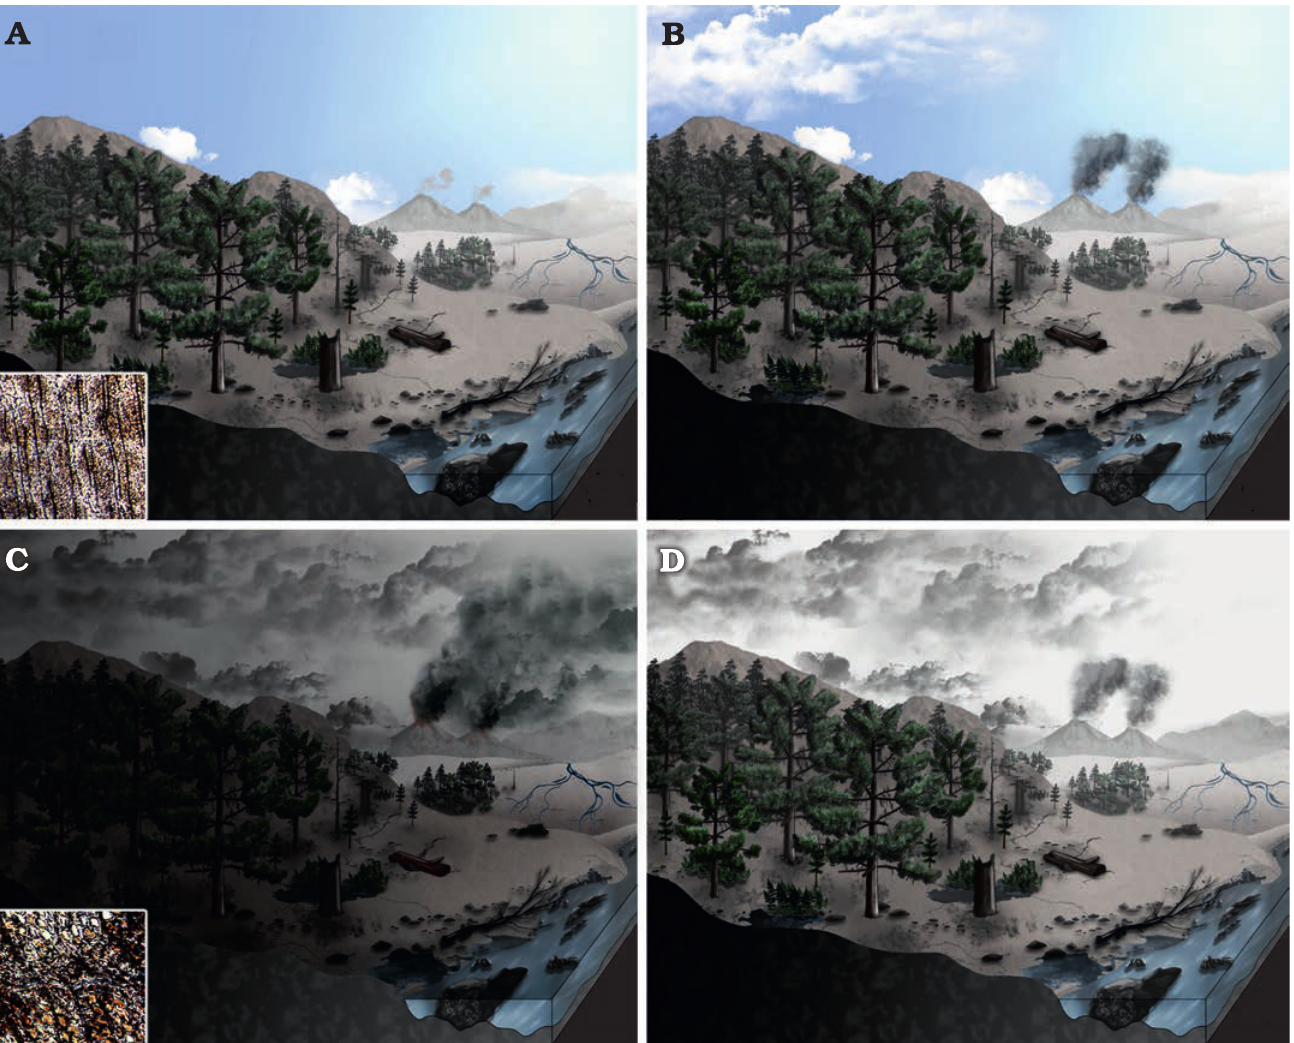
Fig. 10. Hypothetical scenario in the Estancia El Álamo locality (Santa Cruz Province, Argentina, Berriasian–Valanginian) following volcanic distur­ bances. A . Pre­eruption stage. Seedlings, juvenile, and mature trees of Agathoxylon mendezii sp. nov. growing in a warm almost subtropical palaeoenvi­ ronment. Note volcanoes in the distance. Photo shows wood with slightly growth ring. B . Initial eruption stage. Volcanoes begin to eject silicate dust and sulfur compounds into the stratosphere. C . Climax eruption stage. Aerosol layer thickness is markedly increased producing the decrease of the surface air temperature below subzero values. Photo shows wood damaged by frost. D . Post­eruption stage. Volcanoes activity begins to cease and temperature begins to rise to original